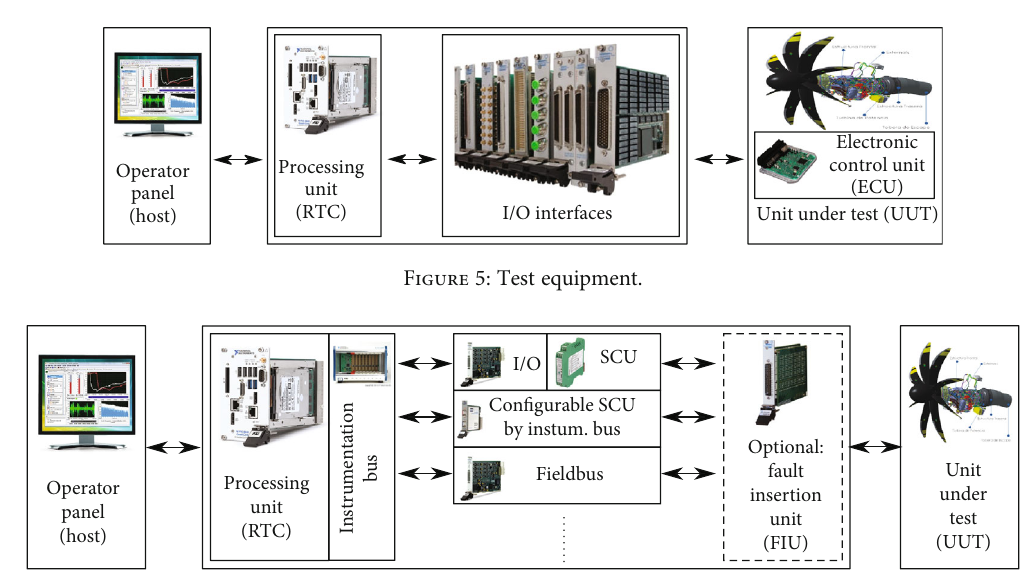
Figure 4: HIL veri fi cation paradigm.